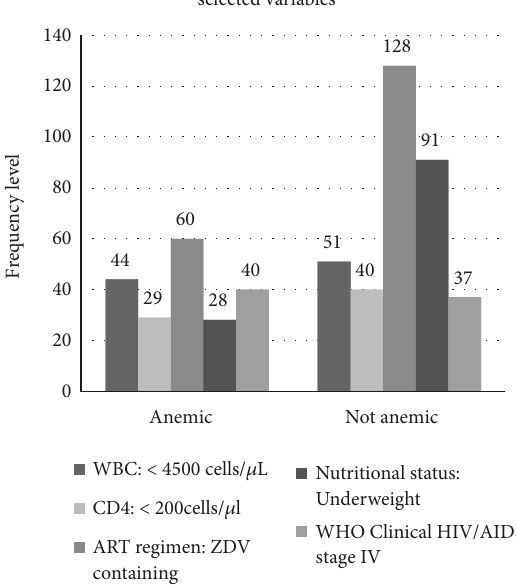
Figure 1: Frequencyof anemic versus not anemic study participants with selected